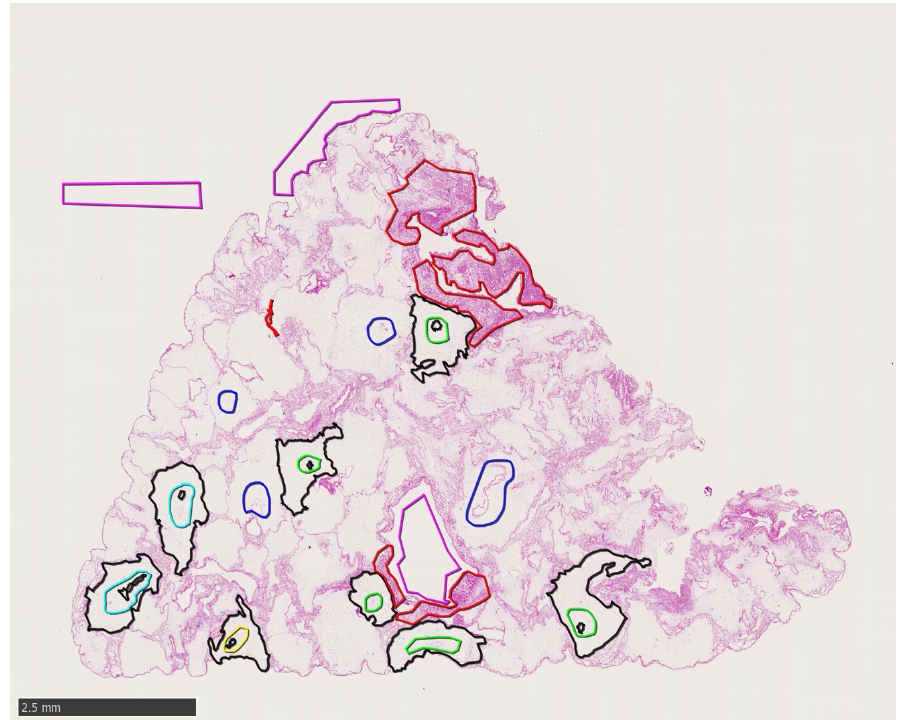
Figure 1. Example of partially annotated H&E Whole Slide Scan (WSS). The manually selected extralobular area is labeled in red. The magenta delineation shows the scan background and the intralobular area is annotated in black. The green, cyan, blue, and yellow annotation represents the rough delineation of the central